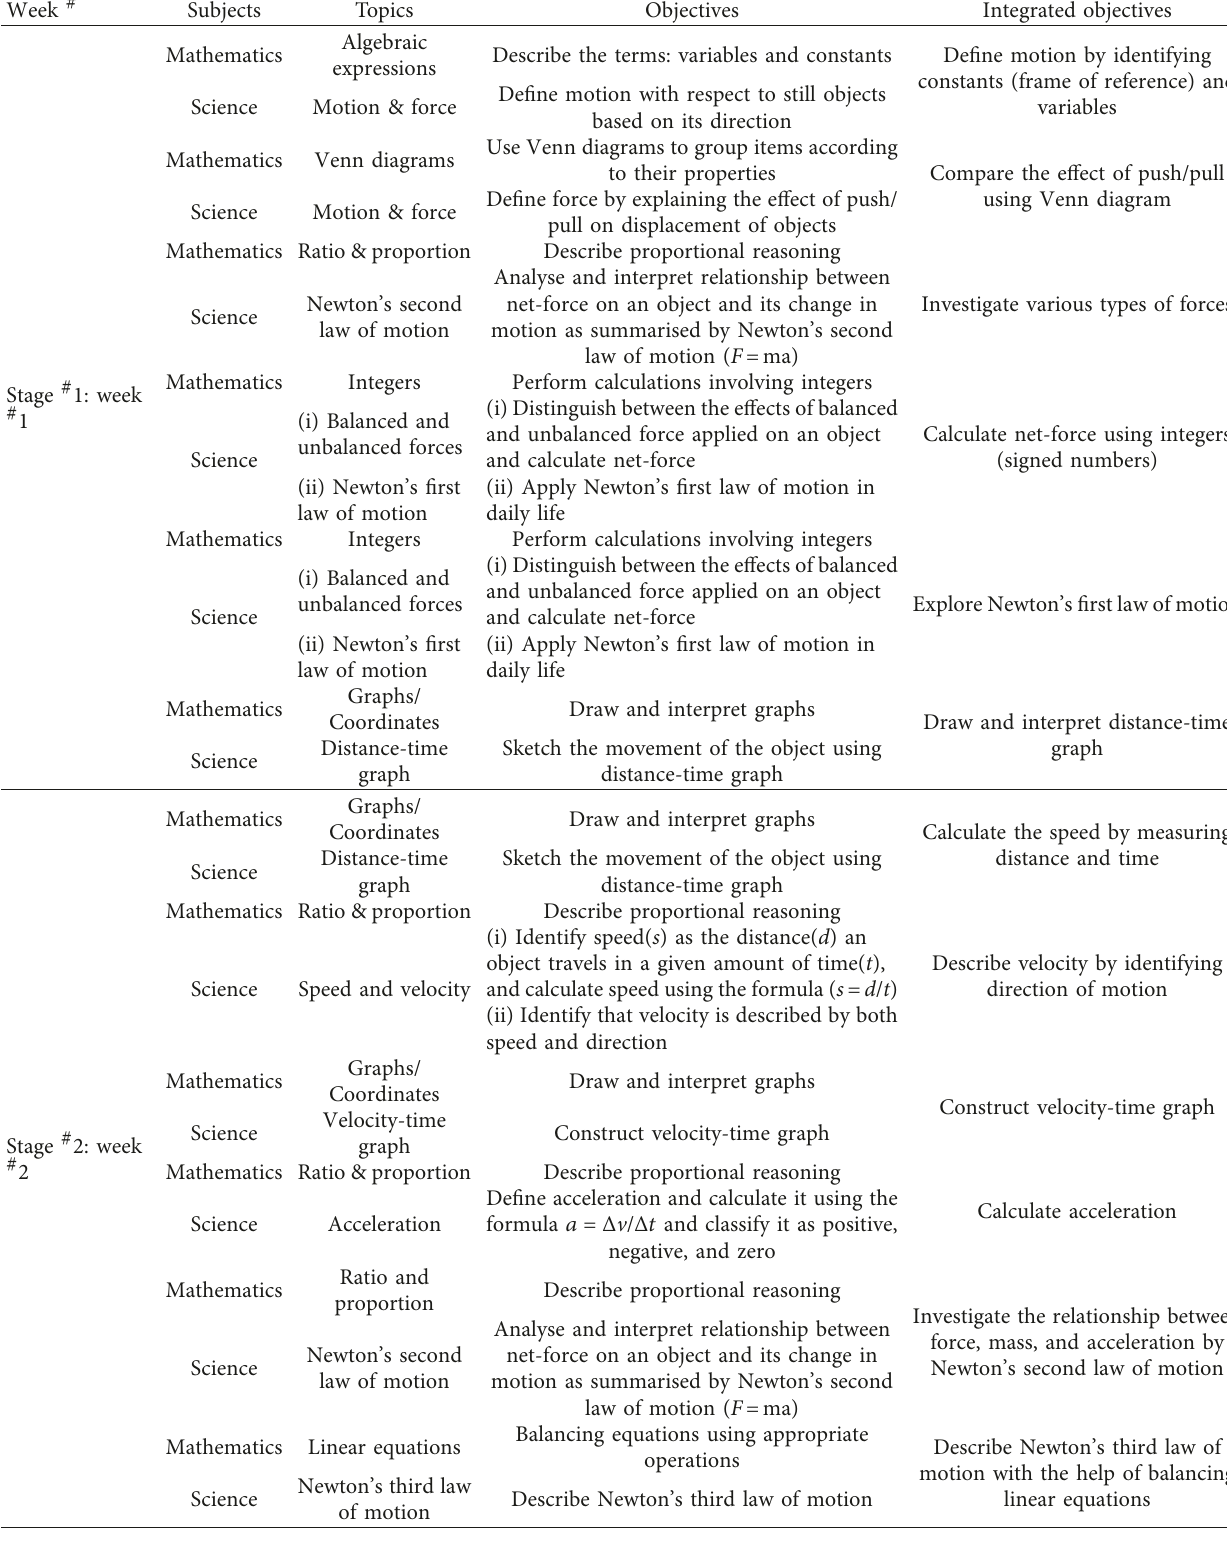
Table 2: Details of activities to be carried